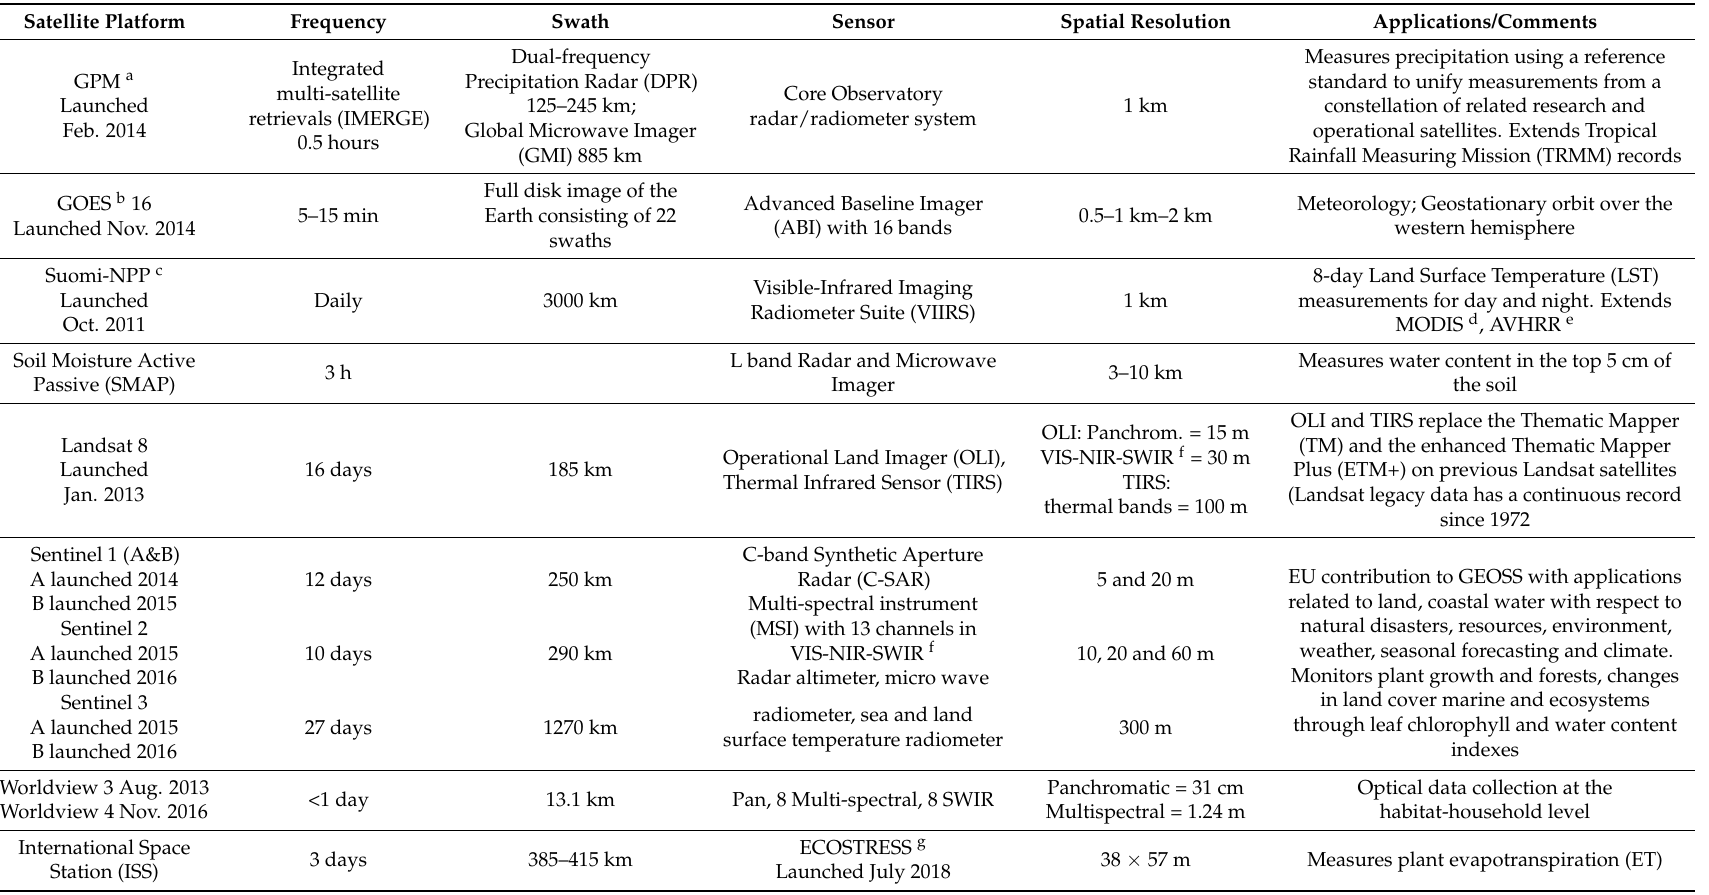
Table 1. Recently launched Earth-observing satellite resources for mapping and modelling GeoHealth